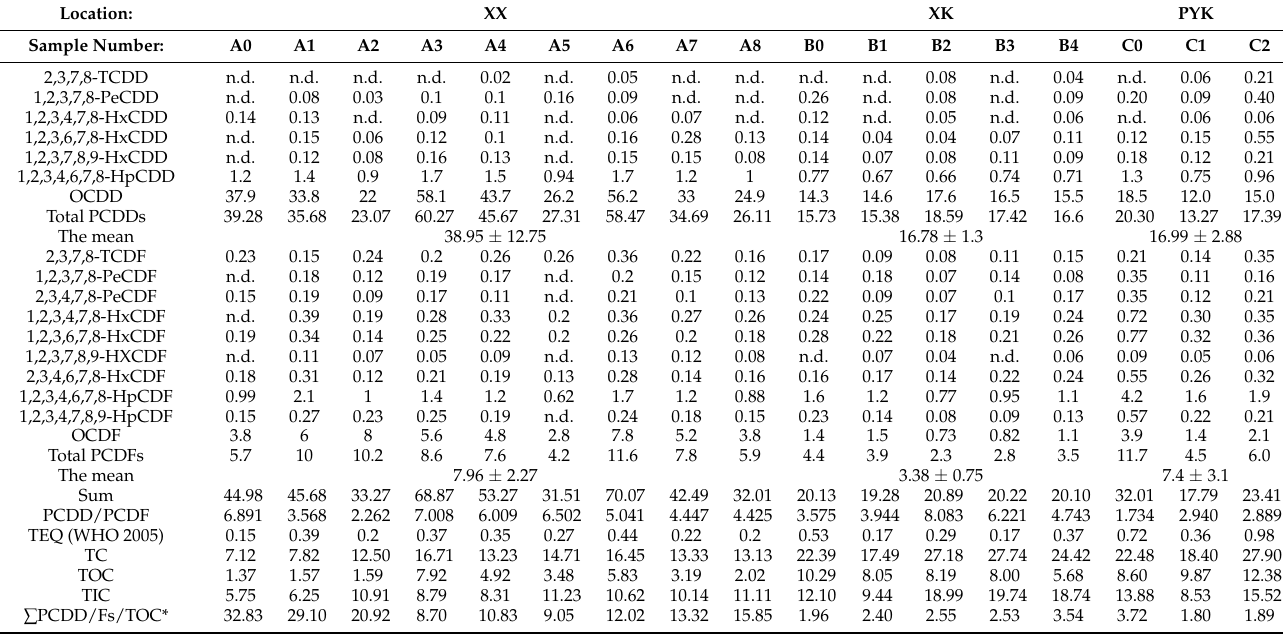
Table 2. PCDD/F concentrations (pg/g d.w.), TEQ (pg/g d.w.) and carbon contents (mg/g d.w.) in samples from the sediment cores of Xiangxi River ( n = 18).